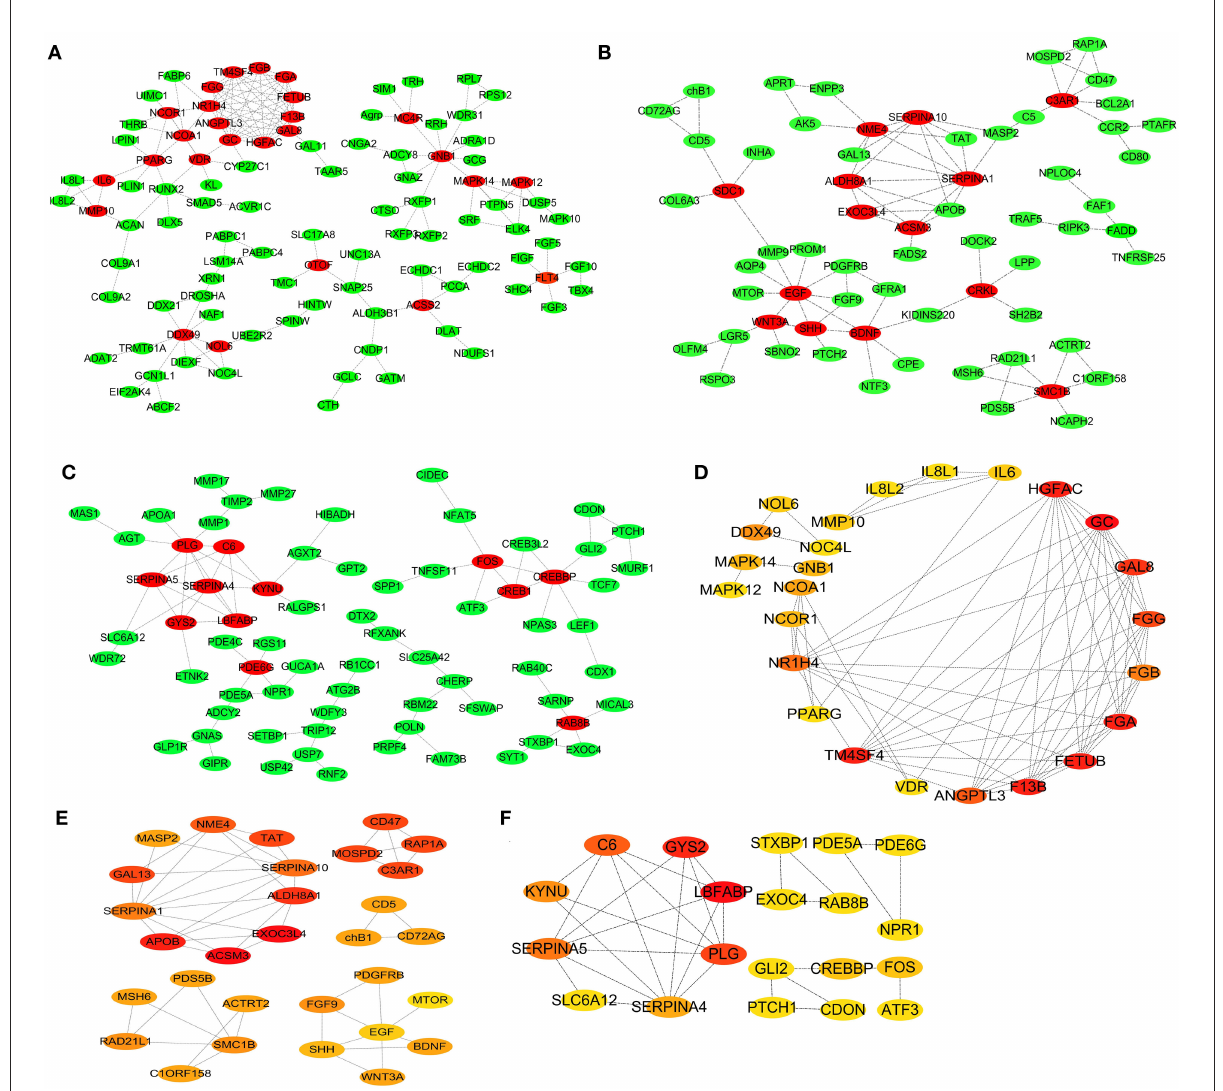
FIGURE5 PPI Network and hub genes for the breed-special DEGs. (A–F) represented the PPI network and the Hub genes analysis for the breed-special DEGs in the hearts of SG, TB, and DRW chickens. The significance of genes highlighted in red, orange, and yellow was gradually decreased in the response of the hearts exposed to hypoxia.